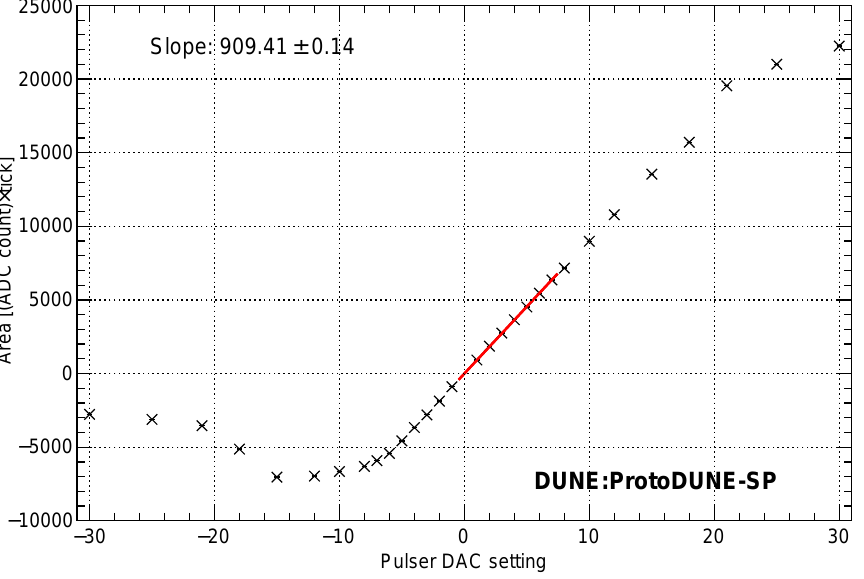
Figure 2. Measured pulse area vs. digital-to-analog converter (DAC) setting for a typical collection channel. The red line shows the fit used to extract the gain. This figure is from